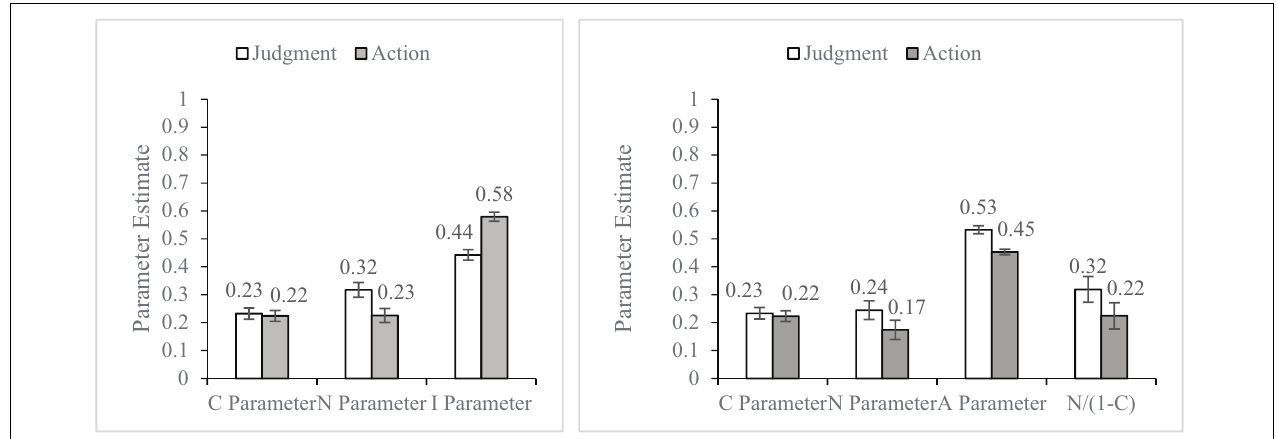
FIGURE A4 | Results of Study 3b by Gawronski et al. (2017) obtained from the CNI model (left) and CAN algorithm (right) . Error bars represent ± 1 SE.